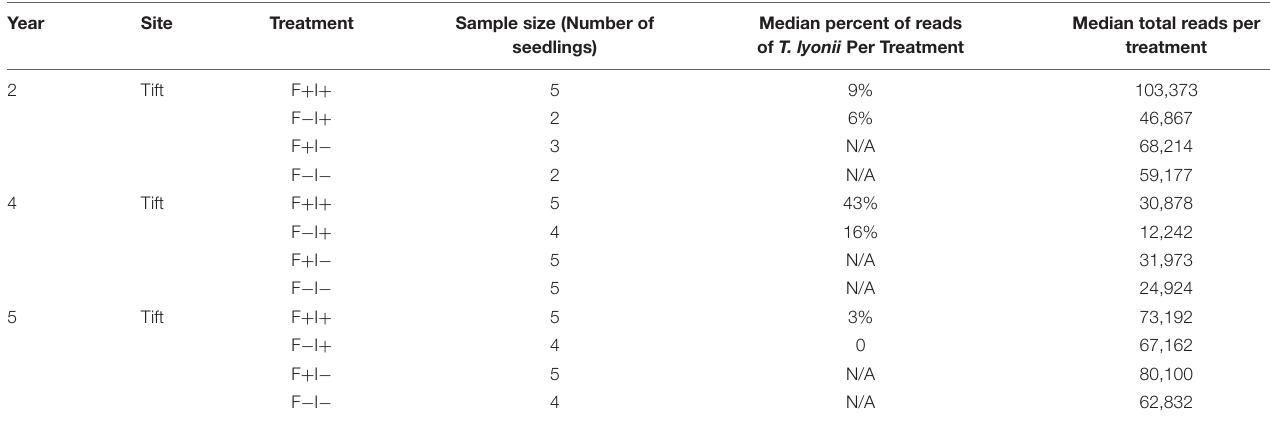
TABLE 5 | Year, site, treatment, sample size, median percent of T. lyonii reads per treatment, and median total reads per treatment for all fungi from the fumigation and inoculation experiment (year 2 = 2015, year 4 = 2017, year 5 = 2018). Year Site Treatment Sample size (Number of